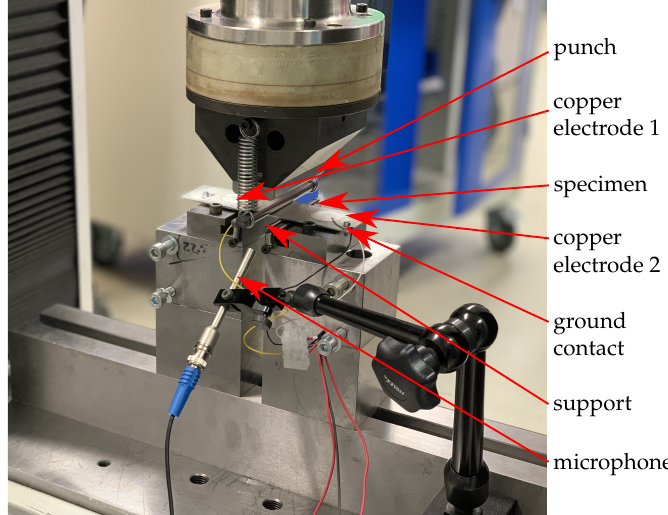
Figure 2. Set-up of the static and dynamic three-point bending